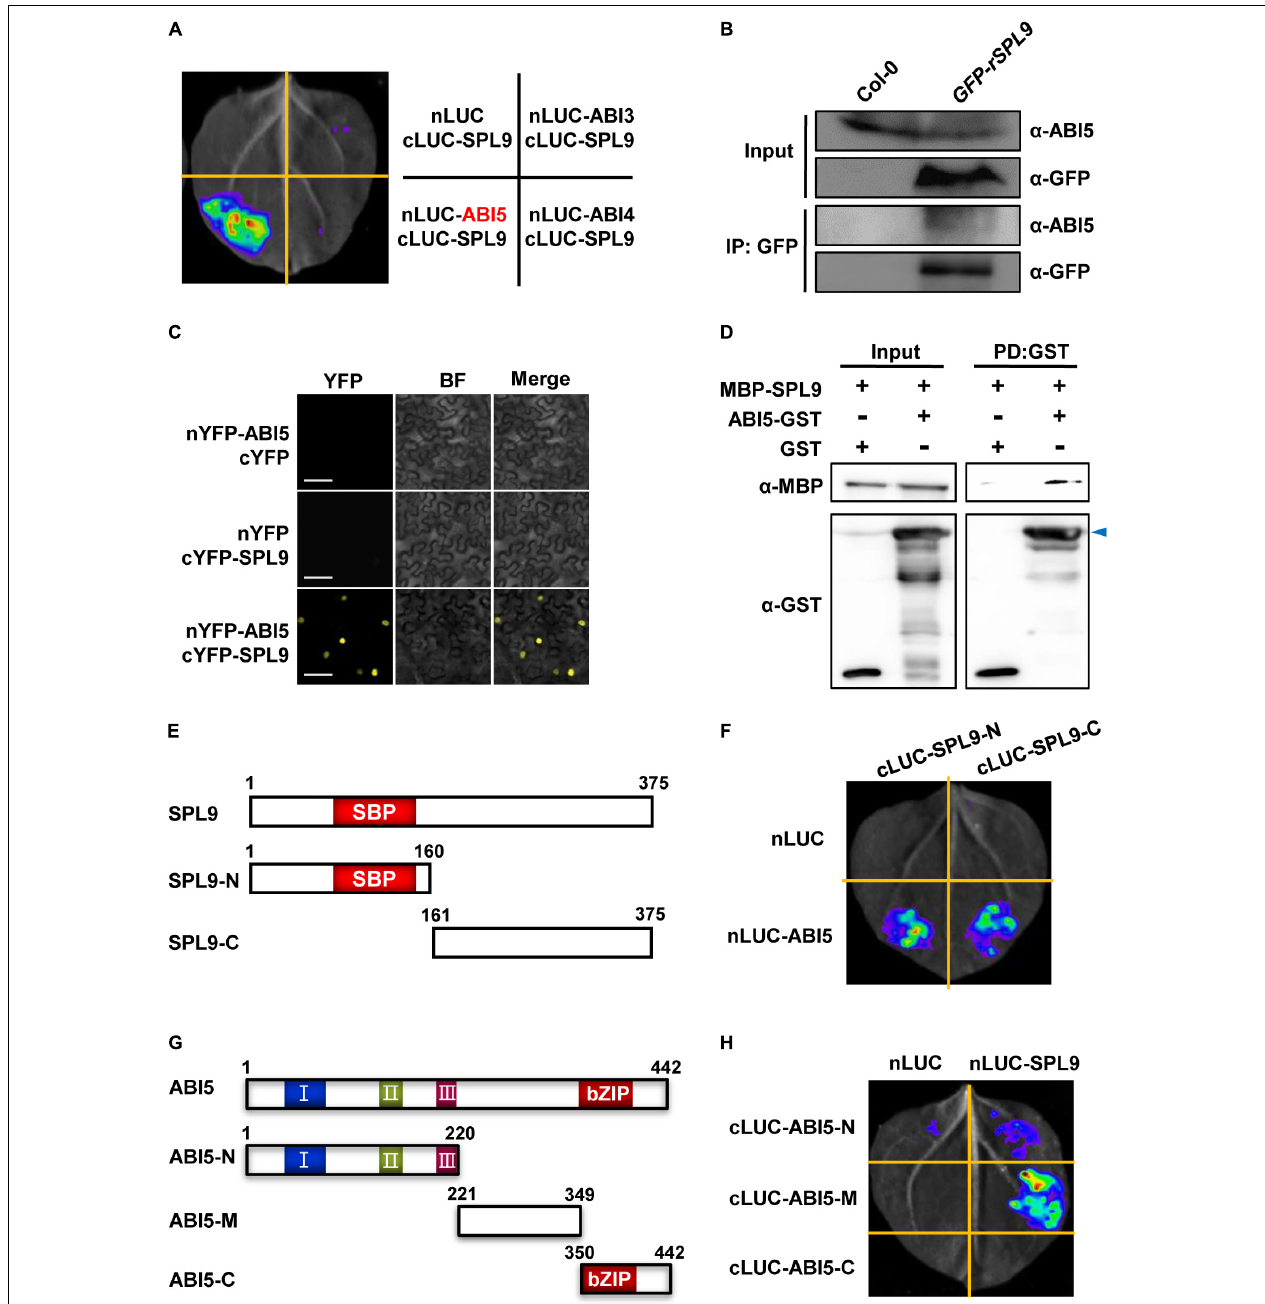
FIGURE 2 | SPL9 physically interacts with ABI5 in vitro and in vivo . (A) Luciferase complementation imaging (LCI) assays showing that SPL9 interacts with ABI5. The cLUC-SPL9 and cLUC-ABI3/ABI4/ABI5 were co-transformed into Nicotiana benthamiana leaves, respectively. (B) Co-immunoprecipitation (Co-IP) assays showing that SPL9 physically interacts with ABI5 in vivo . Total proteins were extracted from the 6-day-old seedlings treated with 50 µ M ABA for 2 h. The immunoprecipitates were detected using anti-ABI5 and anti-GFP antibodies, respectively. (C) Bimolecular fluorescence complementation (BiFC) assays showing the interaction of SPL9 and ABI5. The constructs indicated were co-transformed into N. benthamiana leaves. BF, bright field. Scale bars represent 50 µ m. (D) Pull-down assays showing that SPL9 directly interacts with ABI5 in vitro . Purified MBP-SPL9 proteins could be pulled down by ABI5-GST proteins. MBP was used as a negative control. Arrowhead indicates specific bands. PD, pull down. (E) Schematic representation of the full length as well as truncated versions of SPL9 proteins. The N-terminal region of SPL9 contains the SBP domain. (F) LCI assays showing the interaction between the truncated SPL9 versions and full-length ABI5. (G) Schematic representation of the full length as well as truncated versions of ABI5 proteins. The conserved domains of ABI5 are depicted as I, II, and III (Bensmihen et al., 2002; Lopez-Molina et al., 2003); C-terminal region of ABI5 contains the bZIP domain. (H) LCI assays showing the interaction between the truncated ABI5 versions and full-length